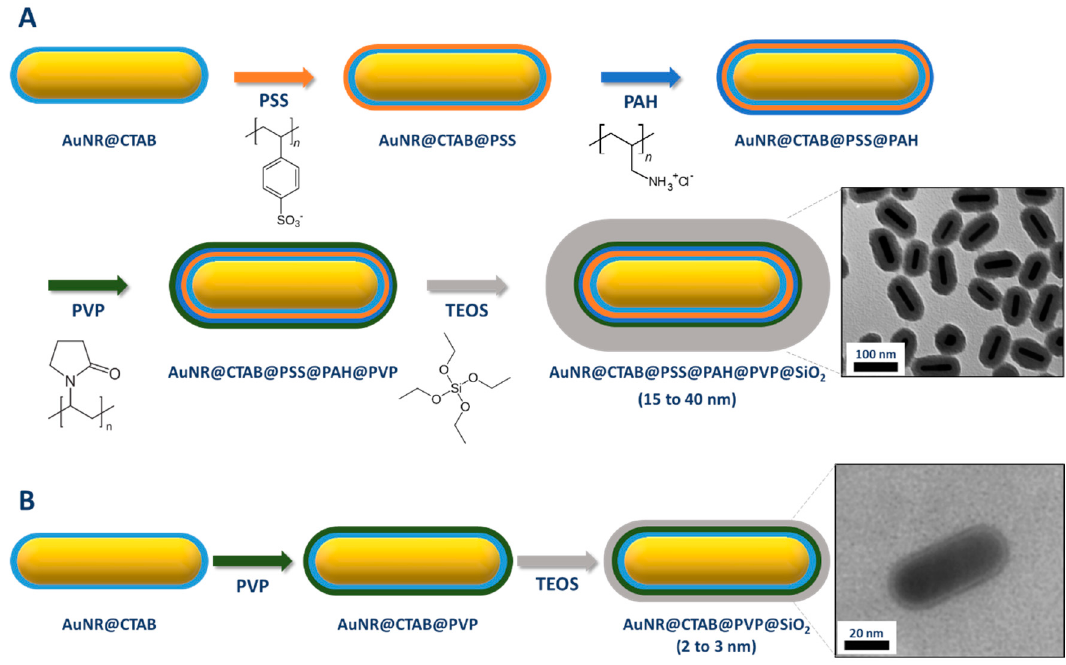
Figure 8. Silica coating on top of CTAB using an layer-by-layer (LBL) approach adapted from ref [75] ( A ) and ref [77] ( B ). and ref [77] ( B